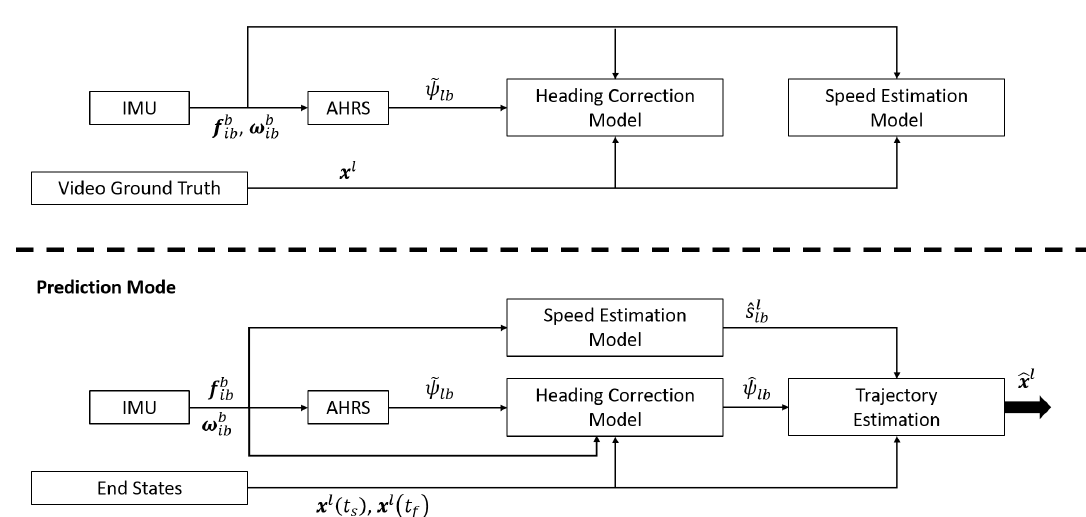
Figure 3. System Pipeline: The algorithm is broken into two modes of operation: Training Mode and Prediction Mode. In training mode , inertial signals are combined with video ground truth data to train regression models that can be used to estimate the speed and heading of the agent. In prediction mode , the trained speed/heading models are used to estimate the speed and heading from the inertial signal input. The estimated speeds/headings are then combined to reconstruct the trajectory of the agent. f b and ω b denote the specific force measured by the accelerometer and the angular rate measured ib ib by the gyroscope, respectively—frame i denotes the Earth-centered inertial frame. ˆ s l estimated speed, ˜ ψ lb is the heading estimate obtained from the AHRS, and ˆ ψ lb is the biobot’s estimated heading after it has been